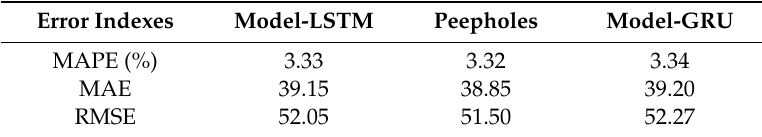
Table 9. The influence of di ff erent hyper parameters on the